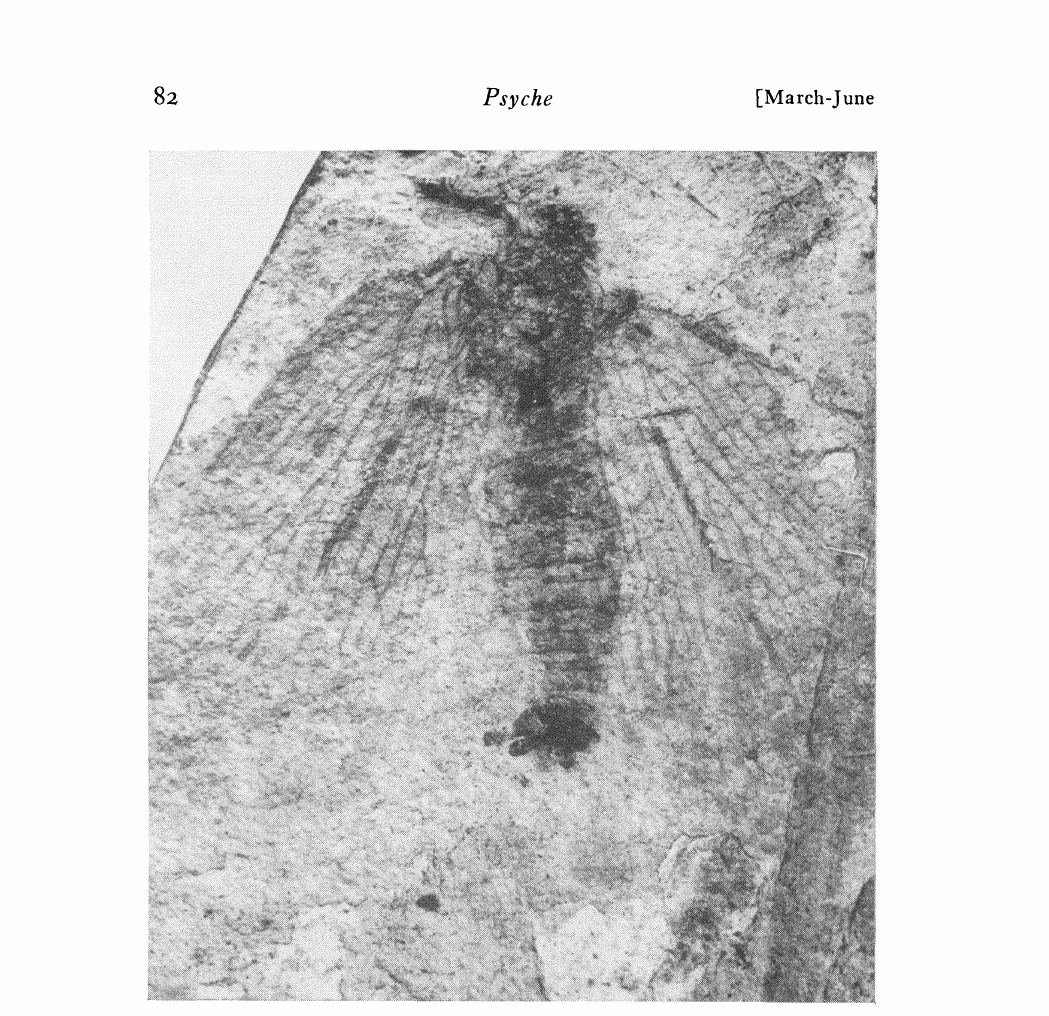
Figure 5. Eomerope tortriciformis Cockerell; photograph of holotype; length of fore wing, 14